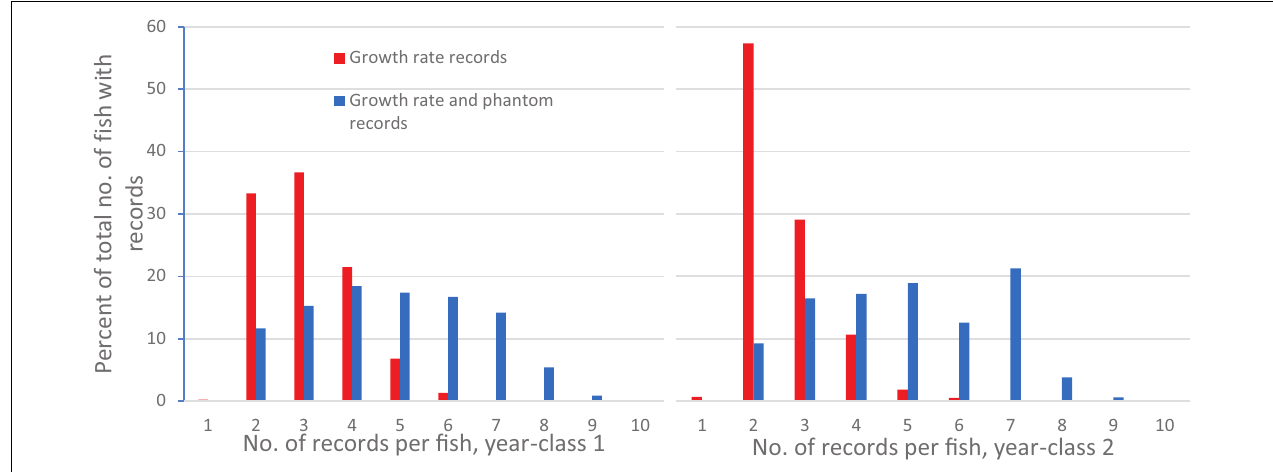
FIGURE 2 | Percent of the total number of fish with growth records with 1 or up to 10 repeated growth records, or 1 or up to 10 growth and phantom records for each of the 2